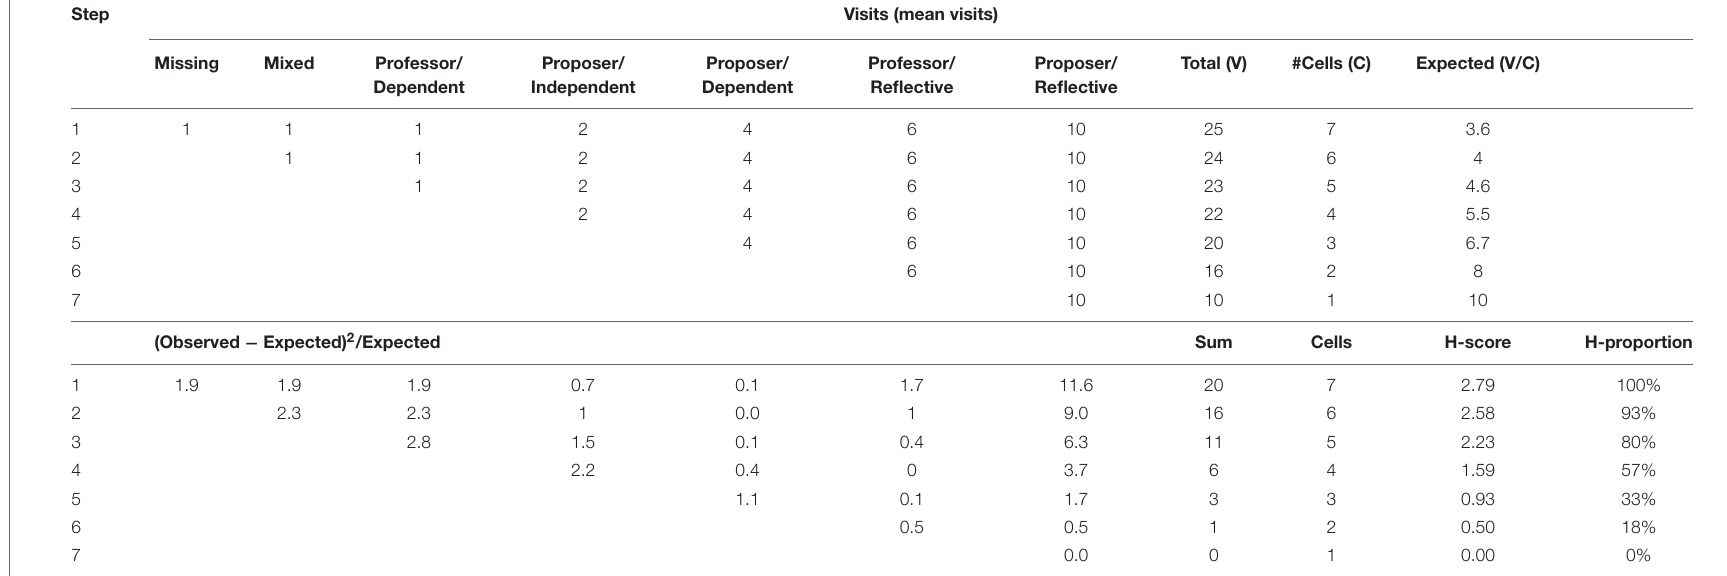
TABLE 5 | Derivation of attractors with heterogeneity score in a seven-used-cell (3 × 5) grid in level 1 change episodes. Step Visits (mean visits)